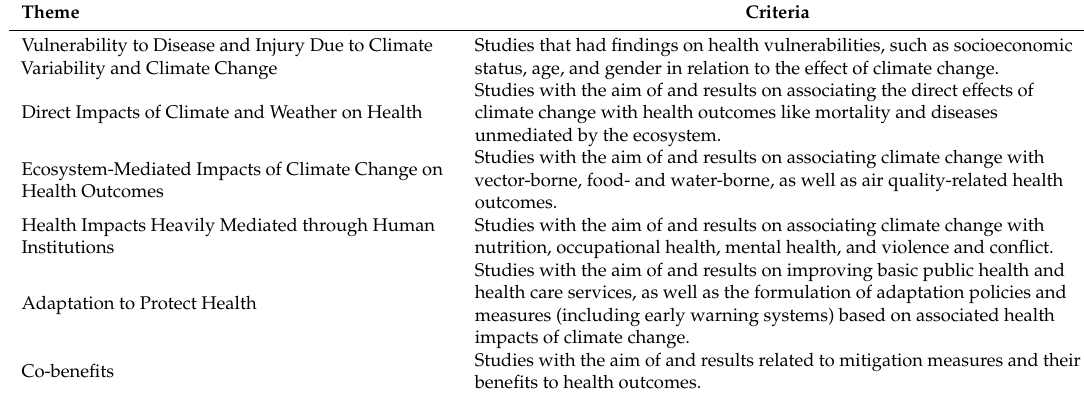
Table 2. Criteria in classifying research themes (adopted from Smith et al.